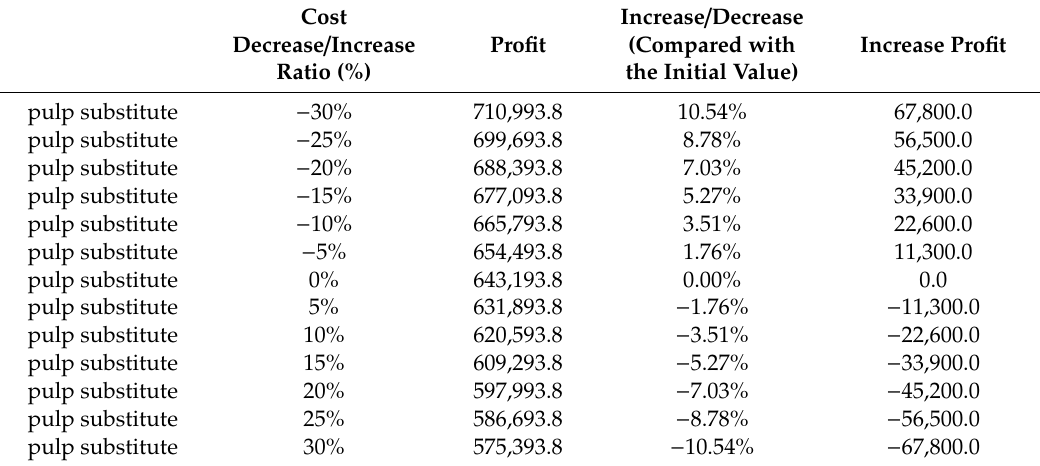
Table 3. Sensitivity analysis on the cost of pulp substitute.